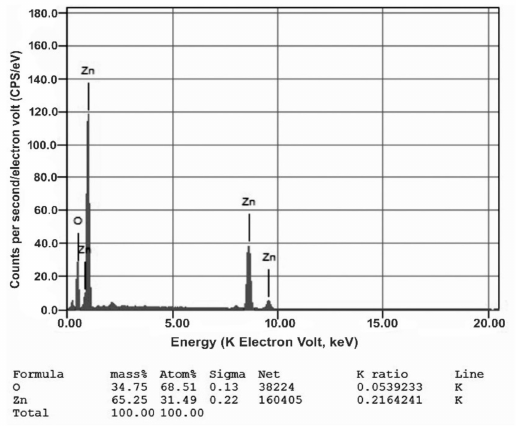
Figure 4. EDX spectrum of phycosynthesized ZnONPs